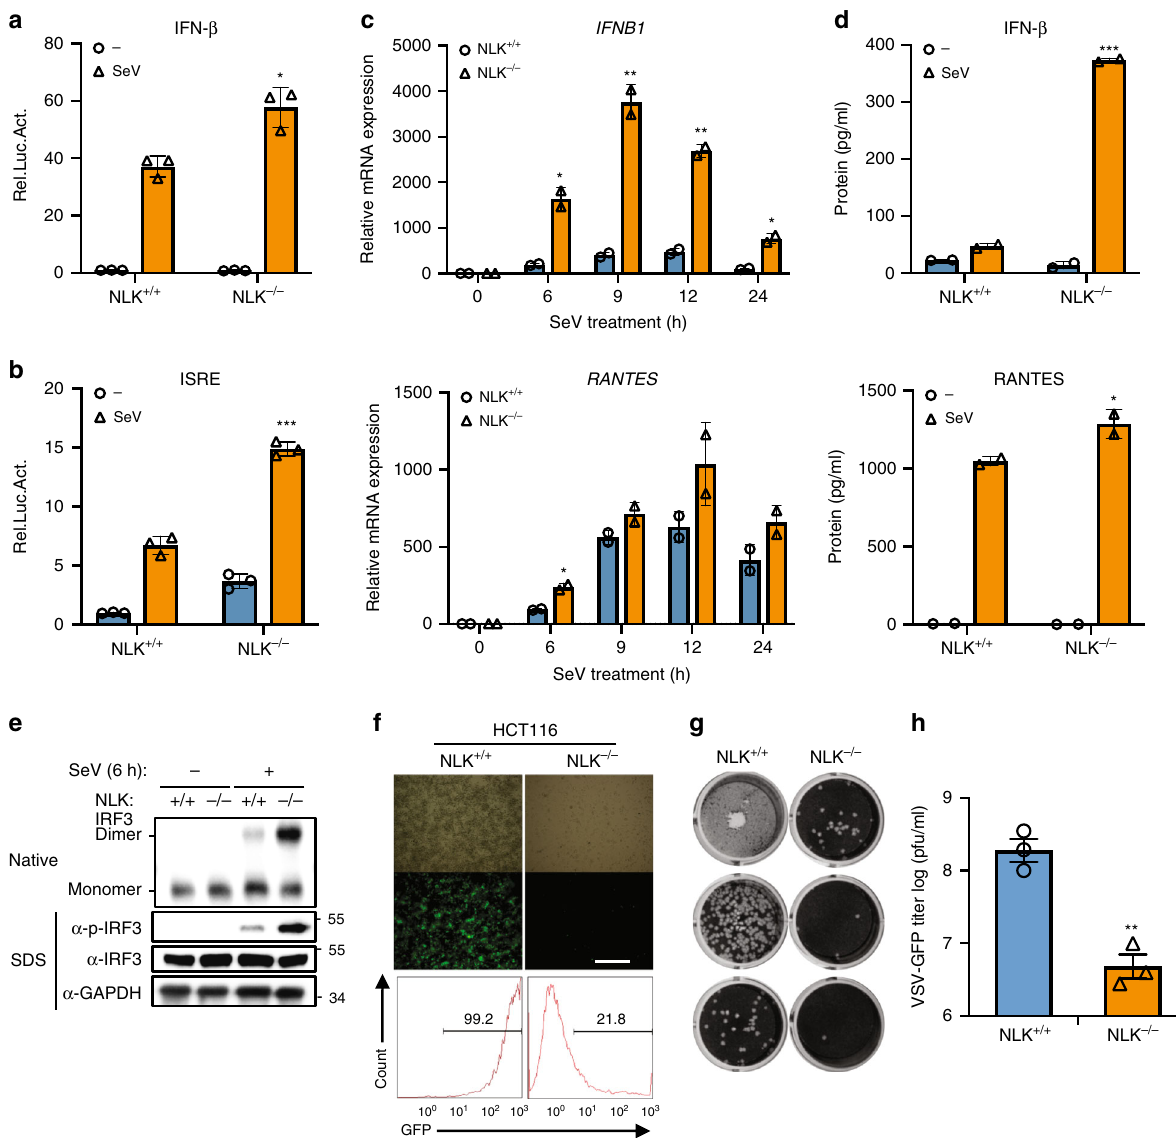
Fig. 3 NLK de fi ciency promotes the cellular antiviral response in HCT116 cells. a , b Effects of NLK de fi ciency on SeV-induced IFN- β and ISRE activation. NLK + / + and NLK − / − HCT116 cells were transfected with the IFN- β or ISRE reporter plasmid (200 ng each). After 24 h of transfection, the cells were infected with SeV for 12 h before the luciferase experiments were performed ( n = 3). c NLK de fi ciency potentiates SeV-induced endogenous IFNB1 and RANTES gene expression in HCT116 cells. NLK + / + and NLK − / − cells were infected with SeV at the indicated time points before performing real-time PCR experiments ( n = 2). d Effects of NLK de fi ciency on the SeV-induced IFN- β and RANTES protein levels. NLK + / + and NLK − / − cells were infected with SeV or left untreated for 18 h. The cell medium was then subjected to ELISA ( n = 2). e NLK de fi ciency facilitates SeV-induced IRF3 dimerization and phosphorylation. NLK + / + and NLK − / − cells were infected with SeV or left untreated for 6 h. The cell lysates were then separated through native (top) or SDS (bottom three panels)-PAGE and immunoblotted with the indicated antibodies. f NLK de fi ciency in HCT116 cells inhibits VSV-GFP infection. NLK + / + and NLK − / − cells were infected with VSV-GFP at an MOI of 0.01 for 12 h before phase-contrast and fl uorescence microscopy and fl ow cytometry analysis. Scale bar is 500 µ m. g , h NLK de fi ciency in HCT116 cells potentiates the antiviral response. NLK + / + and NLK − / − HCT116 cells were infected with VSV at an MOI of 0.1, and the culture supernatants were diluted and added to Vero cells. After fi xation, cells not killed by the virus were stained with crystal violet, and the viral titer was determined ( n = 3). Data are representative of three independent experiments. Data are presented as the mean ± SEM. Statistical signi fi cance was analyzed by ANOVA or Student ’ s t -test (* p < 0.05, ** p < 0.01, *** p < 0.001). Source data ( a – e , h ) are provided as a Source Data fi